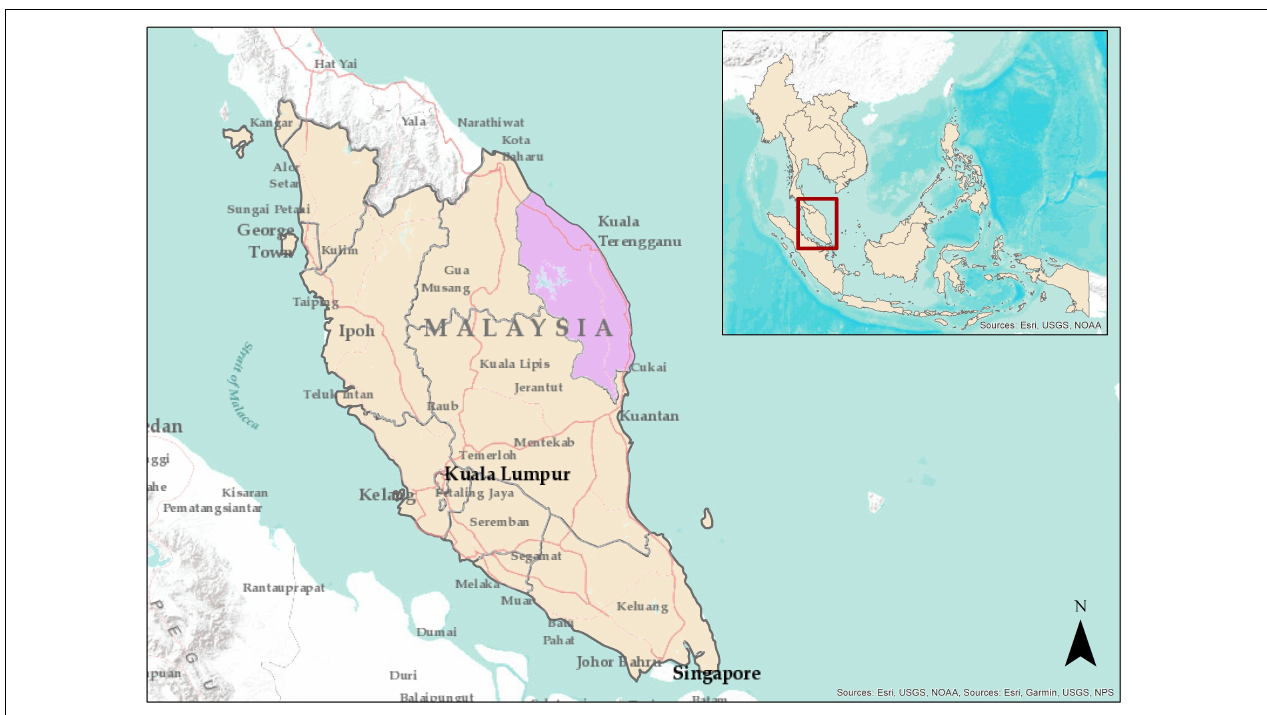
FIGURE 10 | Project Site in